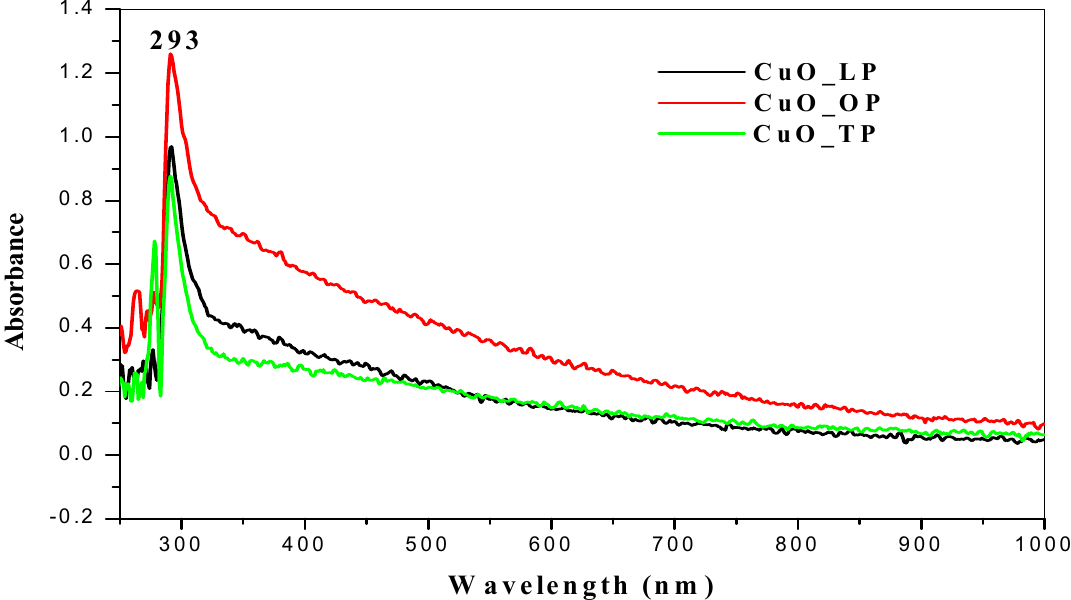
Figure 2. UV-Vis spectra of CuONPs from citrus peels extracted with acetone solvent.